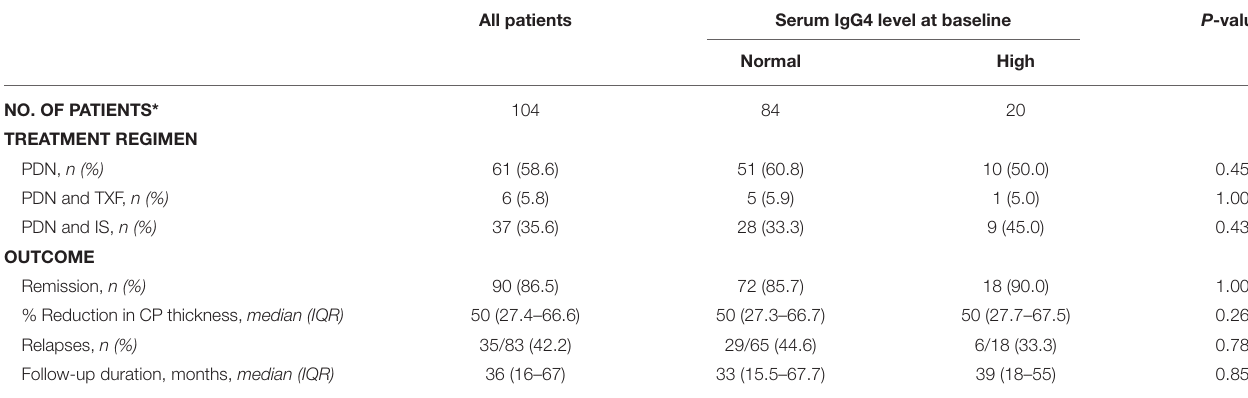
TABLE 2 | Main treatments and outcome of the chronic periaortitis patients included in the study. All patients Serum IgG4 level at baseline P -value Normal High